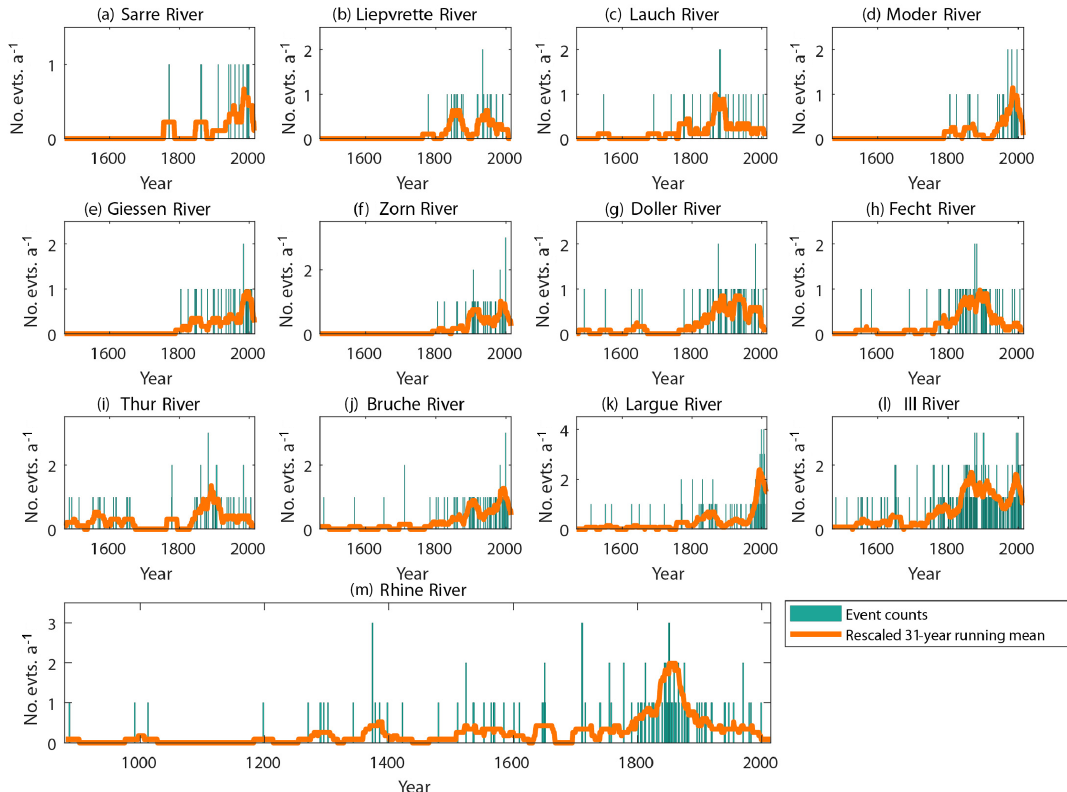
Figure 12. Individual chronologies for the 13 studied rivers: all events (with and without overflow) and underlying smooth trend.